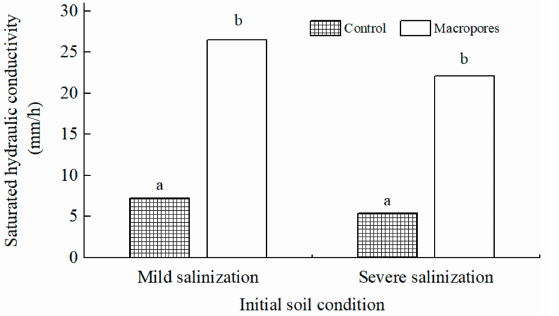
Figure 2. Saturated hydraulic conductivity ( K s) as affected by macropore treatment under two initial soil conditions. Control: soil columns without macropore treatment. Macropores: artificial macropores with sandy fillings (AMSF)